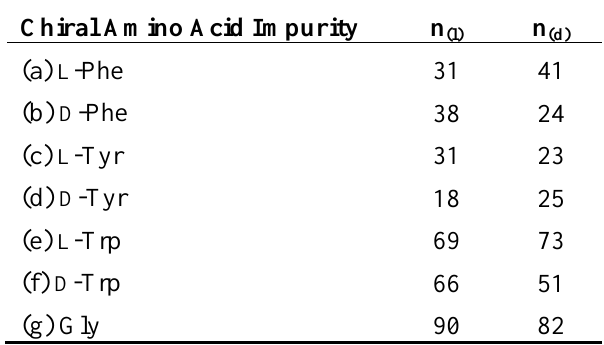
Table 1. Amino acid effect on the crystallizations of NaClO under water-air induced crystallization conditions. The addition of chiral hydrophobic amino acids favors a preferred handedness in the sodium chlorate crystallization, the achiral hydrophobic amino acid Gly does not induce a significant bias.